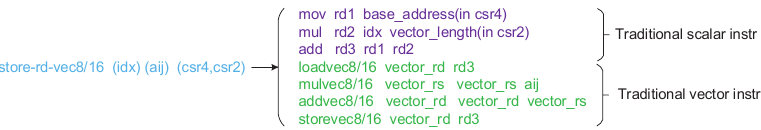
Figure 16. The load-rd-add-rs-store-rd-vec8/16 instruction for GAT equivalent.